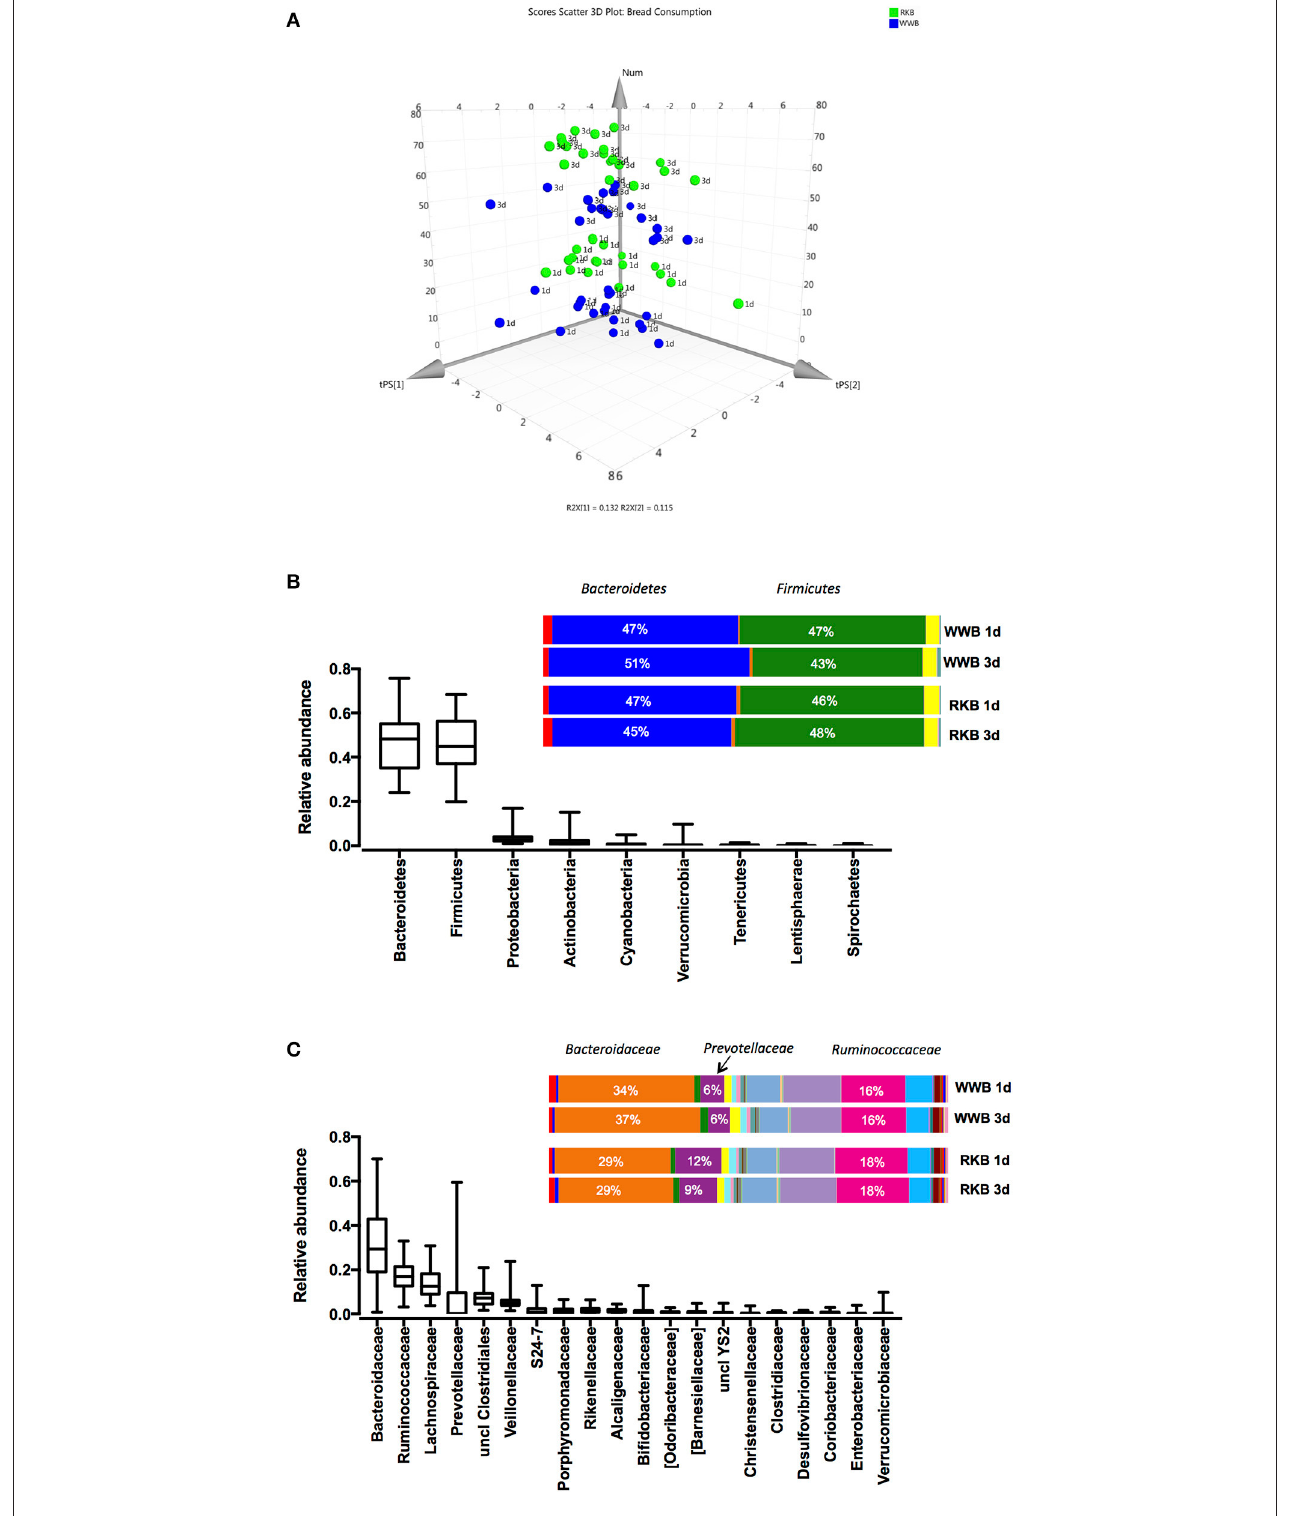
FIGURE 1 | 3D PCA plot of data points for each participant after WWB and RKB product consumption during 1 or 3 d period (A) ; Relative abundance of OTUs taxonomically assigned to bacterial phyla (B) and family (C) level, of all participants at all visits (unfilled boxplots, n = 74) or per test occasion (colored bars), where RKB 1d ( n = 18), WWB 1d ( n = 18), RKB 3d ( n = 19), WWB 3d ( n = 19) WWB, white wheat bread; RKB, rye kernel